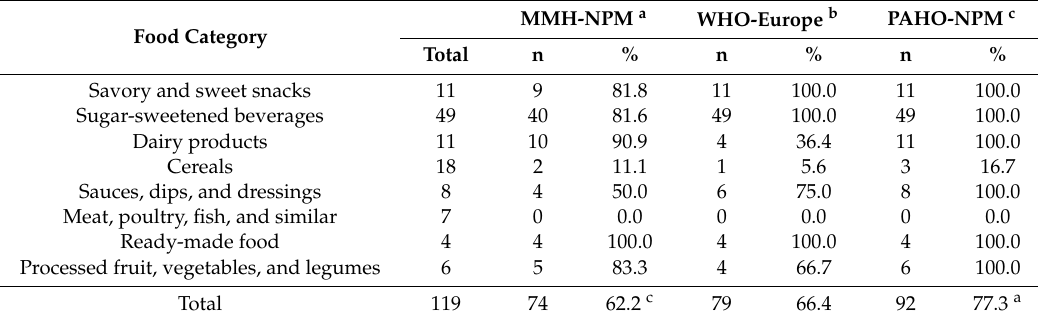
Table 5. The percentages of foods and beverages classified as not healthy according to three nutritional profile